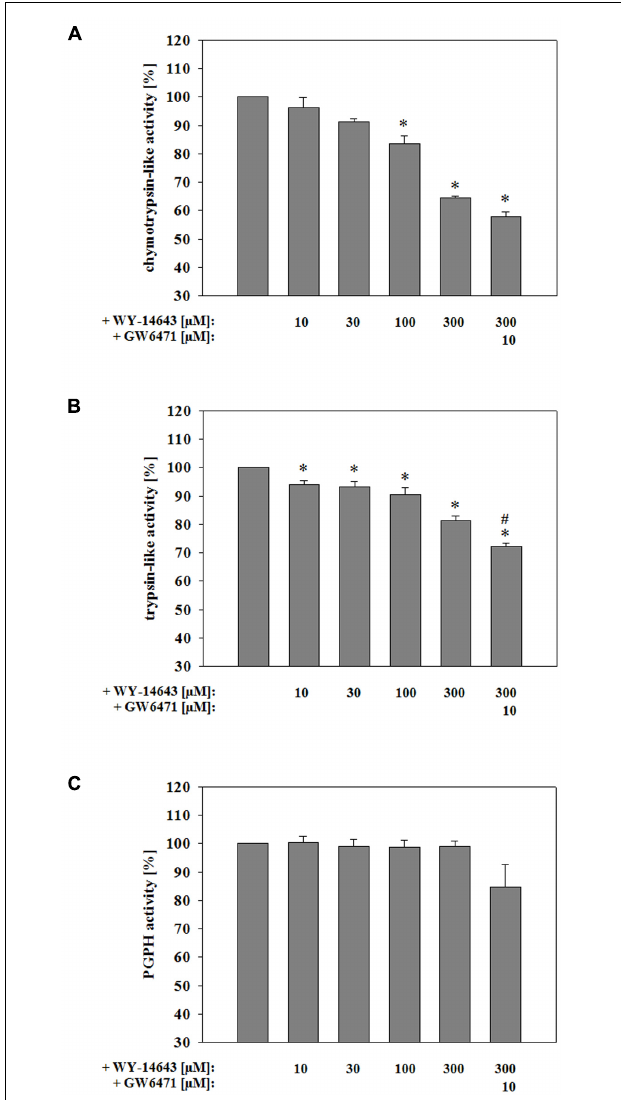
FIGURE 4 | Influence of WY-14643 on proteasomal chymotrypsin-like (A) , trypsin-like (B) , and peptidylglutamyl-peptide hydrolyzing activity (PGPH) (C) activity after isolation of the enzymes from cerebEND cells. Statistical significance was labeled with ∗ vs. NC6 and # vs. OC6 ( p < 0.05). Data are presented as means ± SEM ( n =